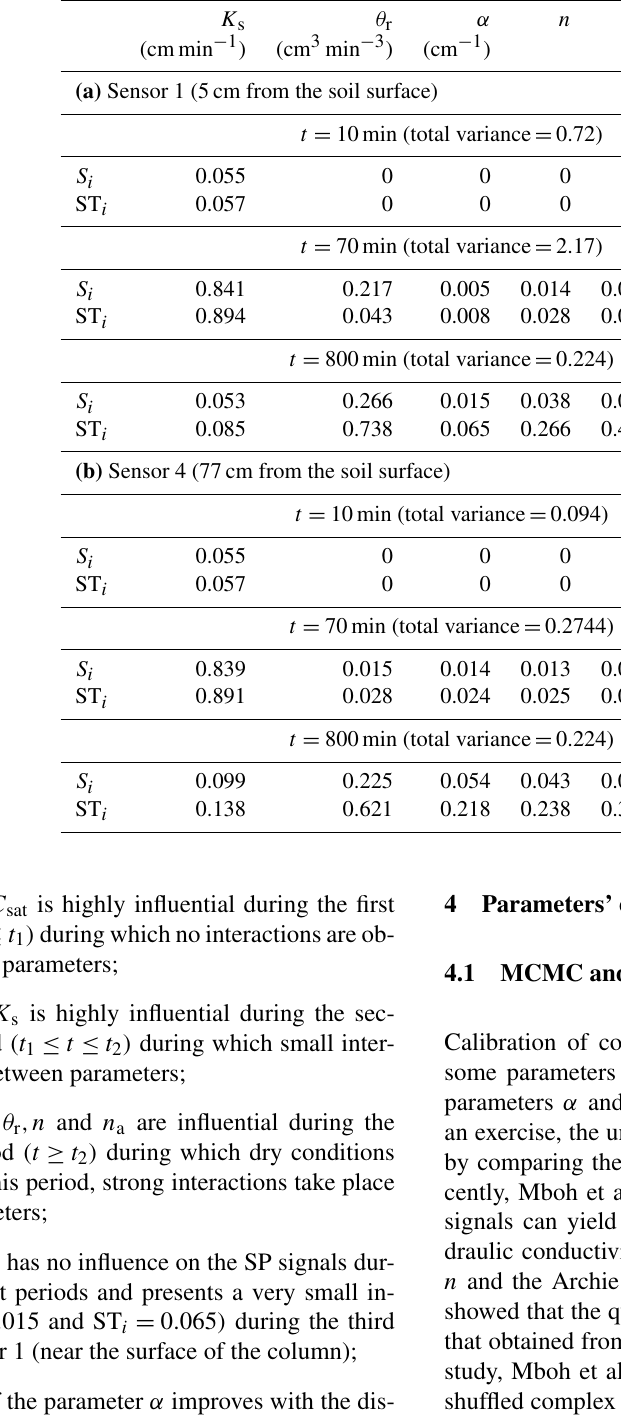
Table 2. The first-order sensitivity index S i and the total sensitivity index ST i for the SP signal 5 (a) and 77cm (b) below the soil surface at different